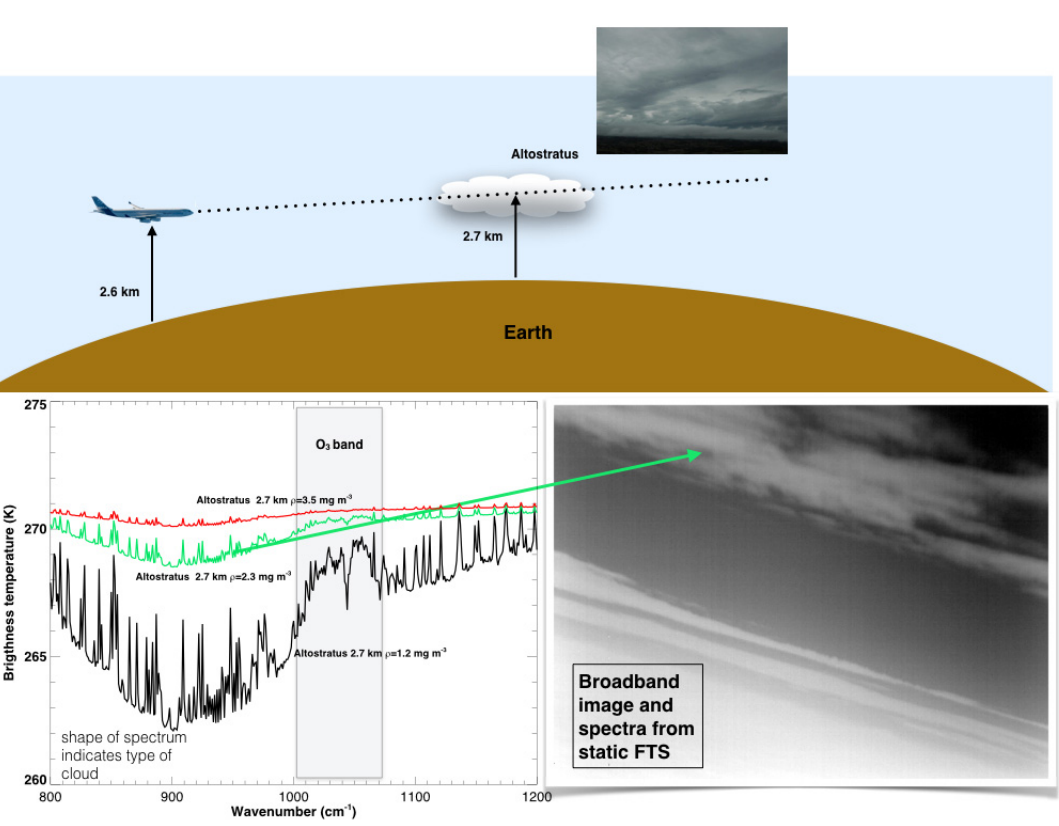
Figure 16. Simulations and measurements for the ASH imager. Top: Simulation set-up for the model calculations of an altostratus cloud. Bottom-left: ART model calculations for altostratus cloud emissivity as a function of wavenumber for three different optical depths (or concentrations, as the path length is the same for all three situations). Bottom-right: Broadband image made during an AIRBUS A340 flight trial of an altostratus cloud.